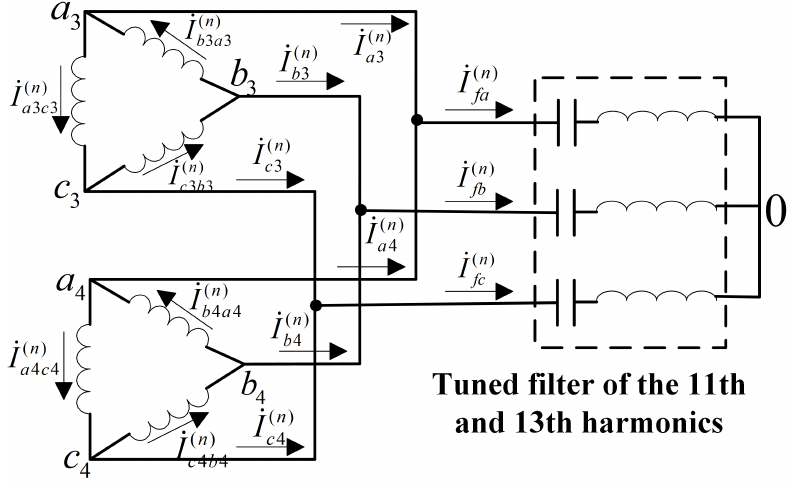
Figure 3. Transfer path of the 11th and 13th harmonic